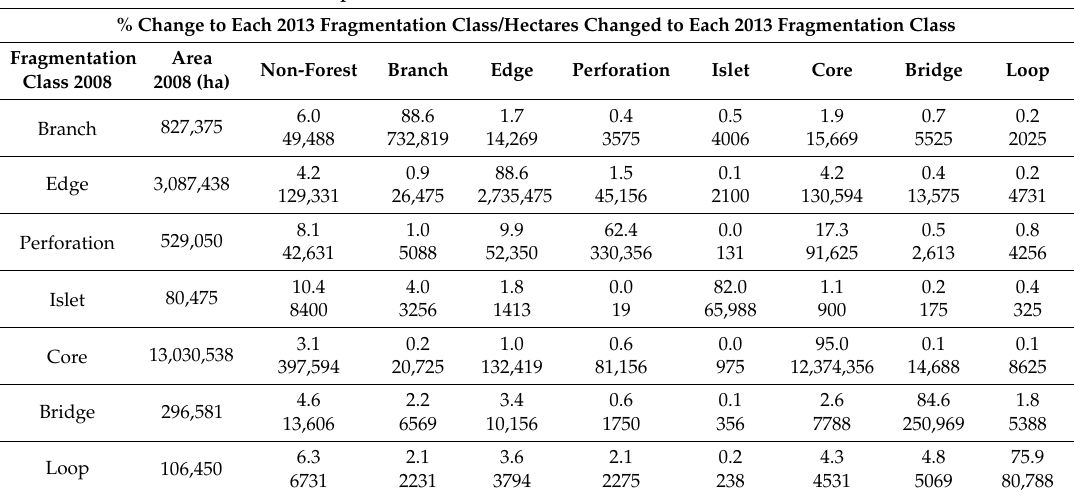
Table C1. Fragmentation classes transition matrices for tropical forest in the 2008–2013 period without differentiating between internal and external classes.